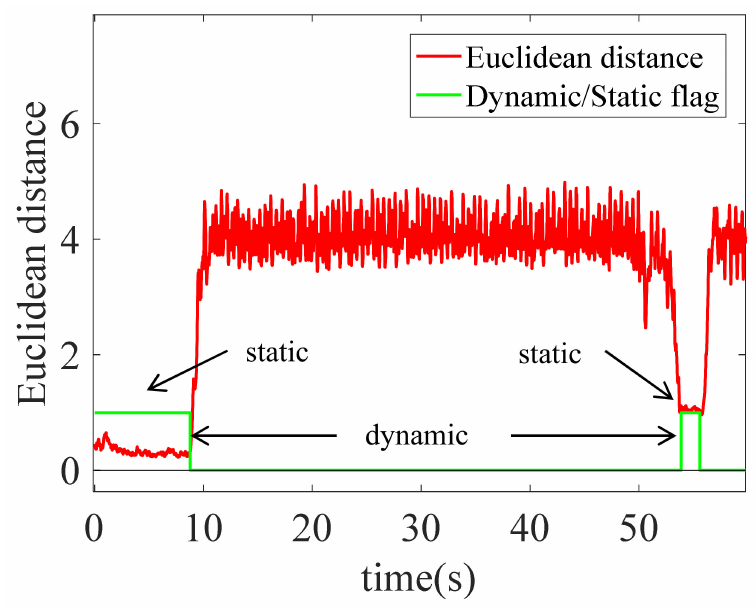
Figure 5. Recognition diagram of dynamic and static